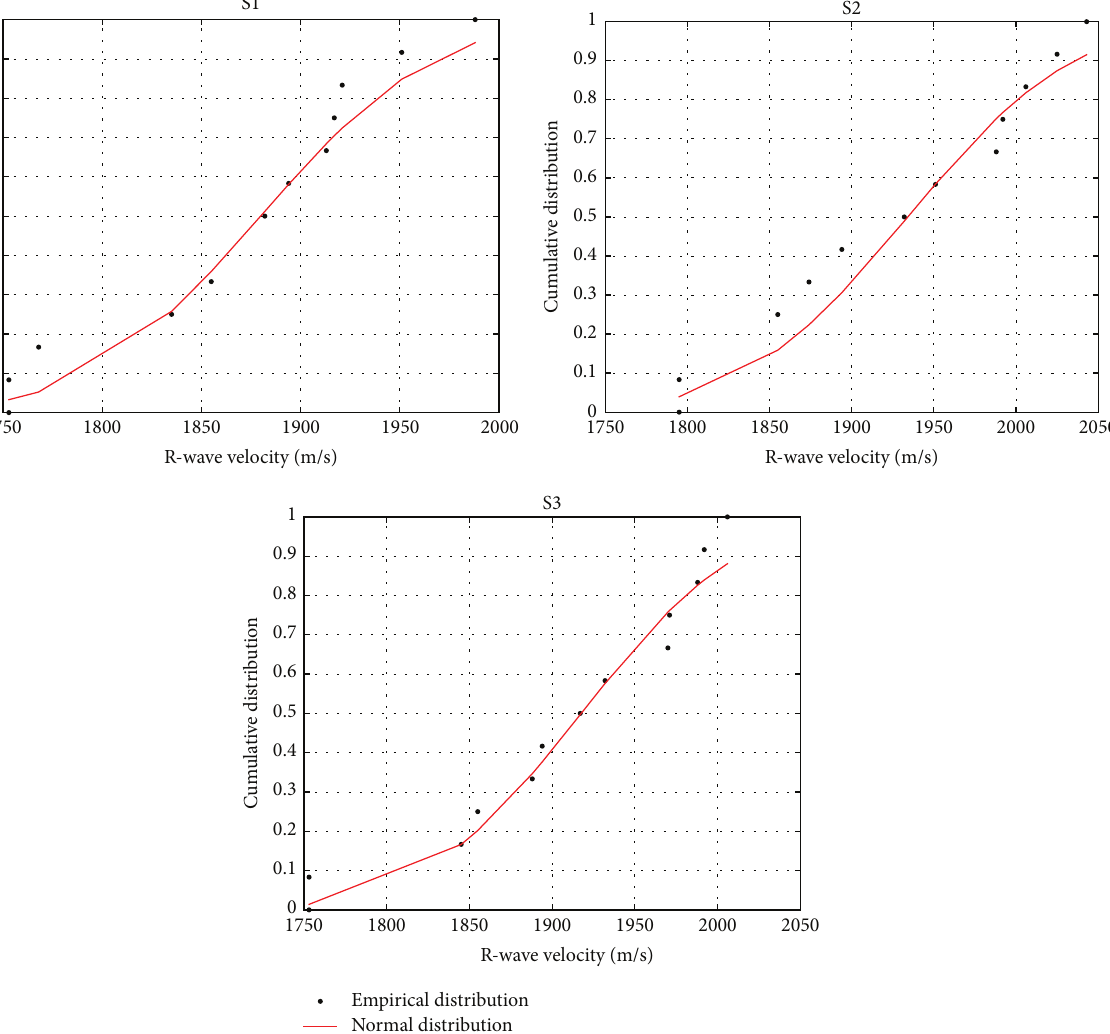
Figure 19: Cumulative normal distribution function of R-wave